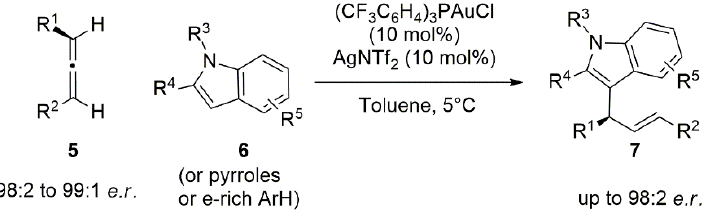
Figure 4. Axial-to-point chirality transfer: intermolecular hydroarylations of allenes ( 5 ).